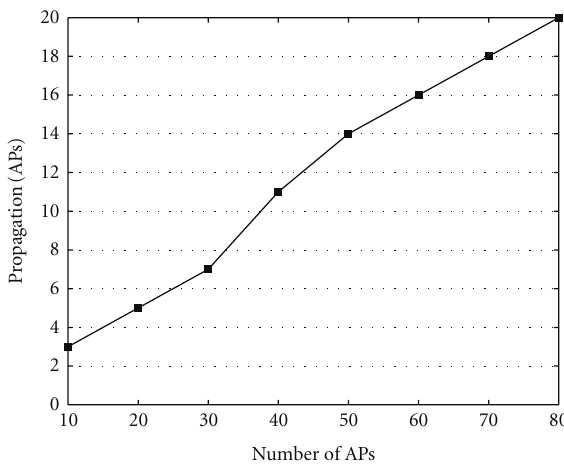
Figure 12: LAC convergence.